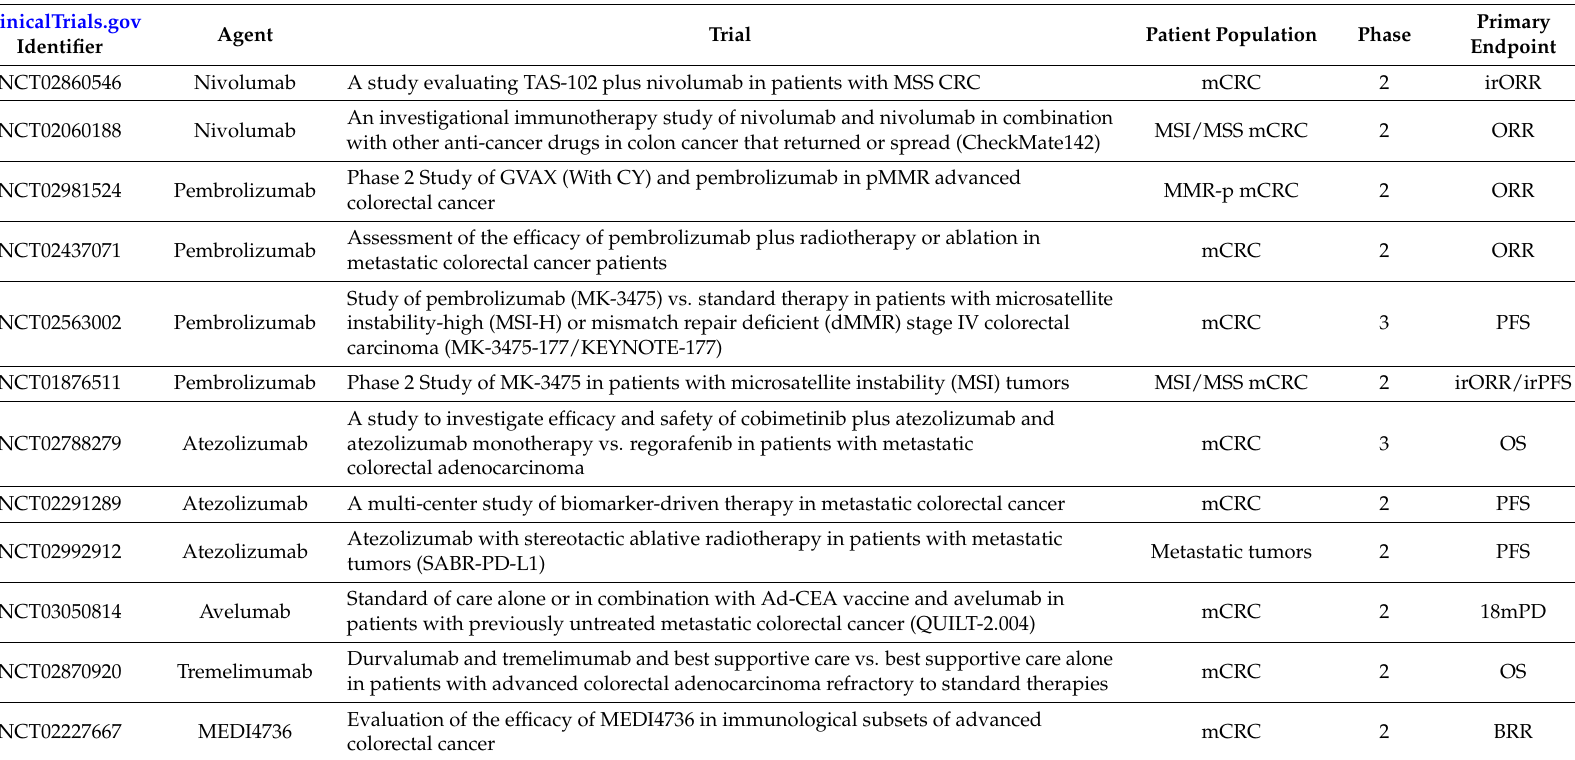
Table 1. Ongoing phase II and III clinical trials on immune checkpoint inhibitors in